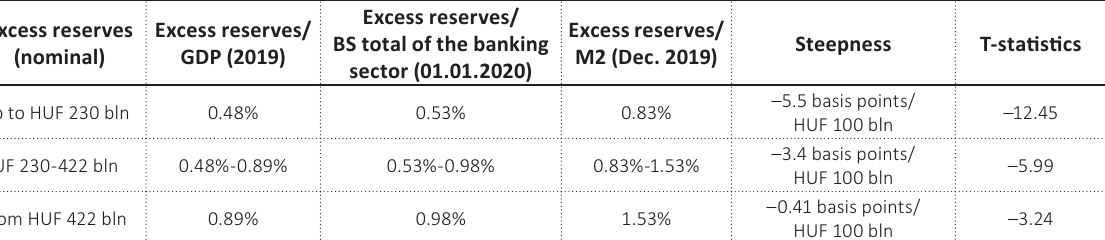
Table 4. Comparable statistics of the Hungarian aggregate liquidity demand curve